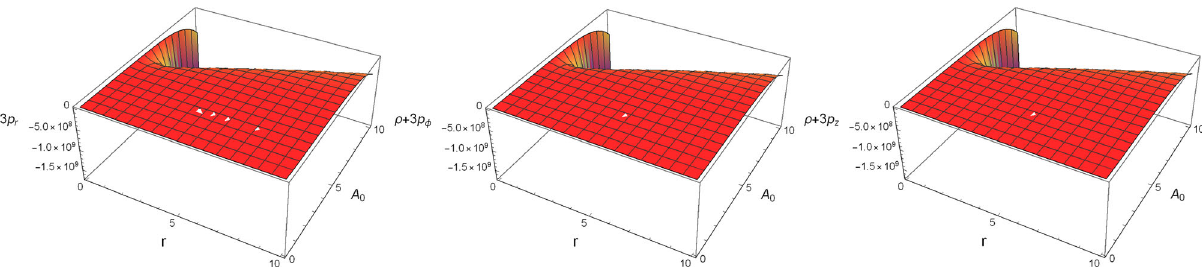
and α = − 0 . 01. CASE